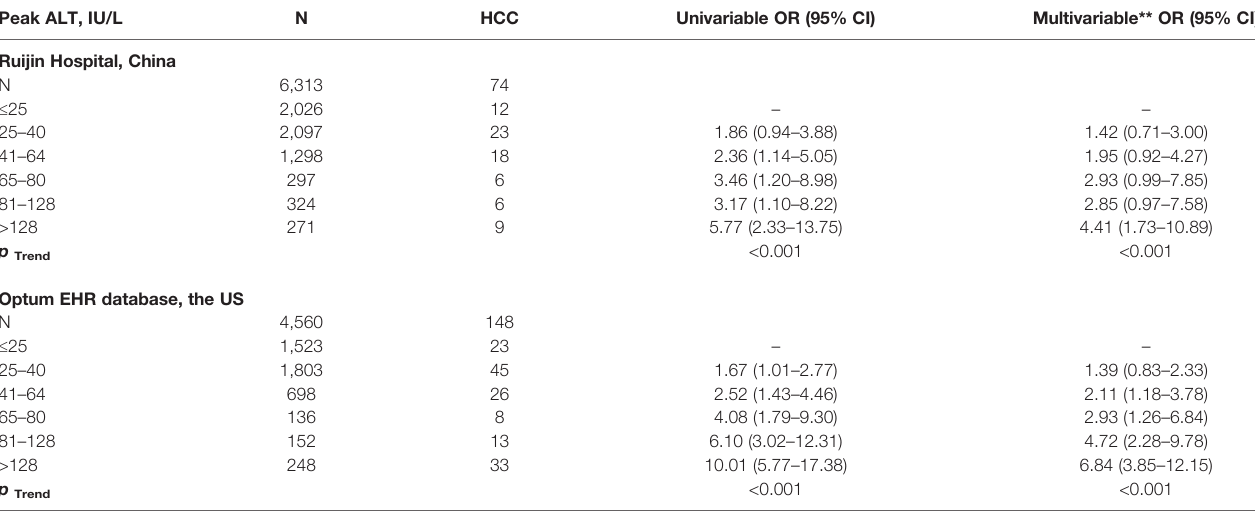
TABLE 2 | Logistic regression model of the association between the peak ALT level* and hepatocellular carcinoma in China and in the US. Peak ALT, IU/L N